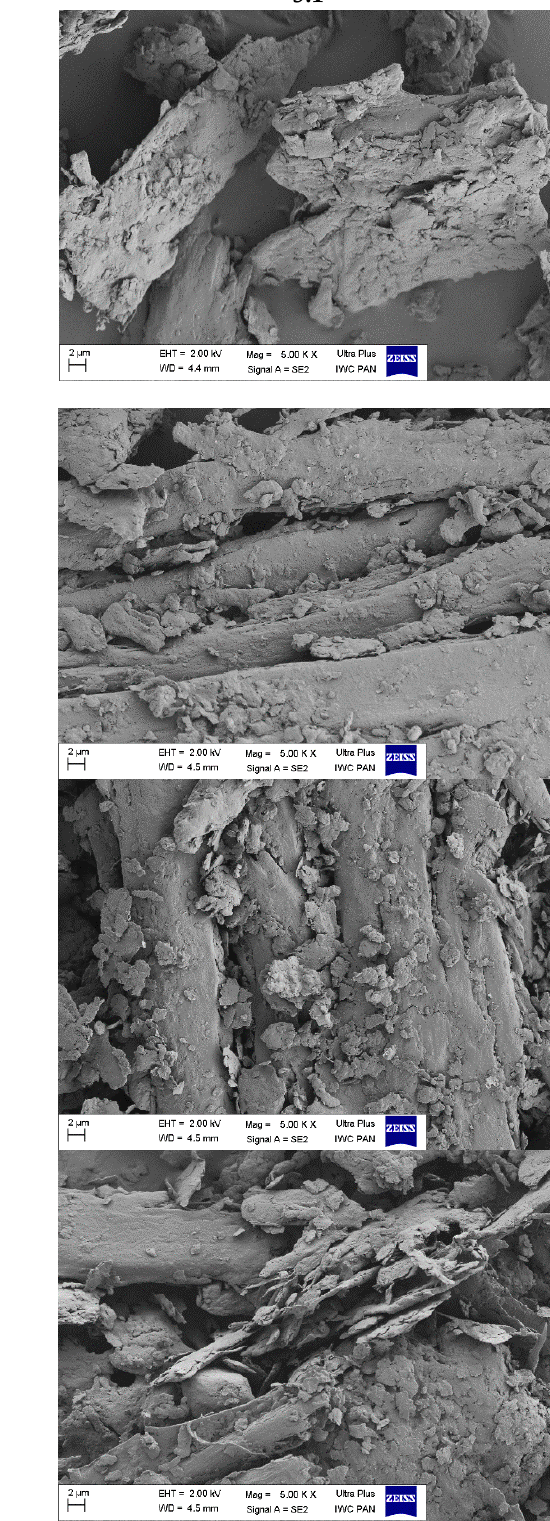
Figure 3. SEM image of straw-montmorillonite.